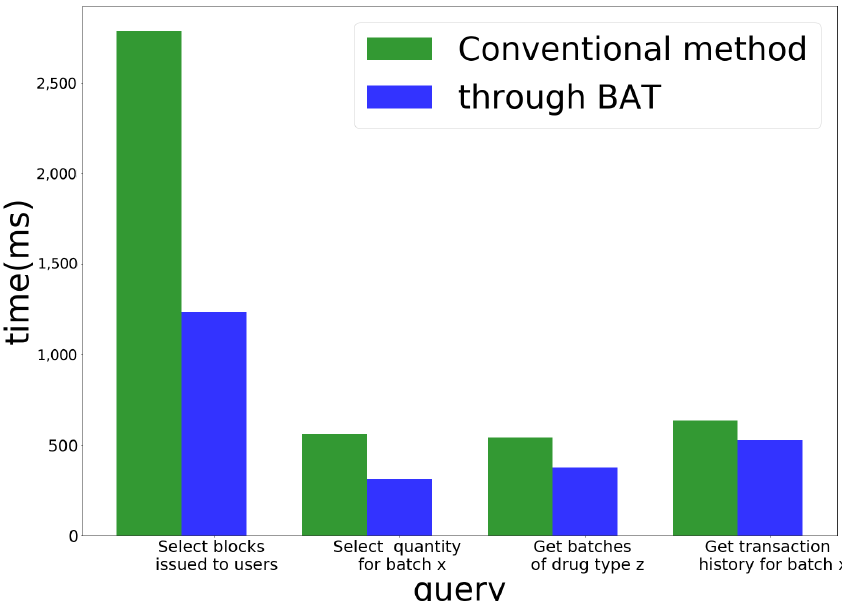
Figure 11. Acquiring data from the